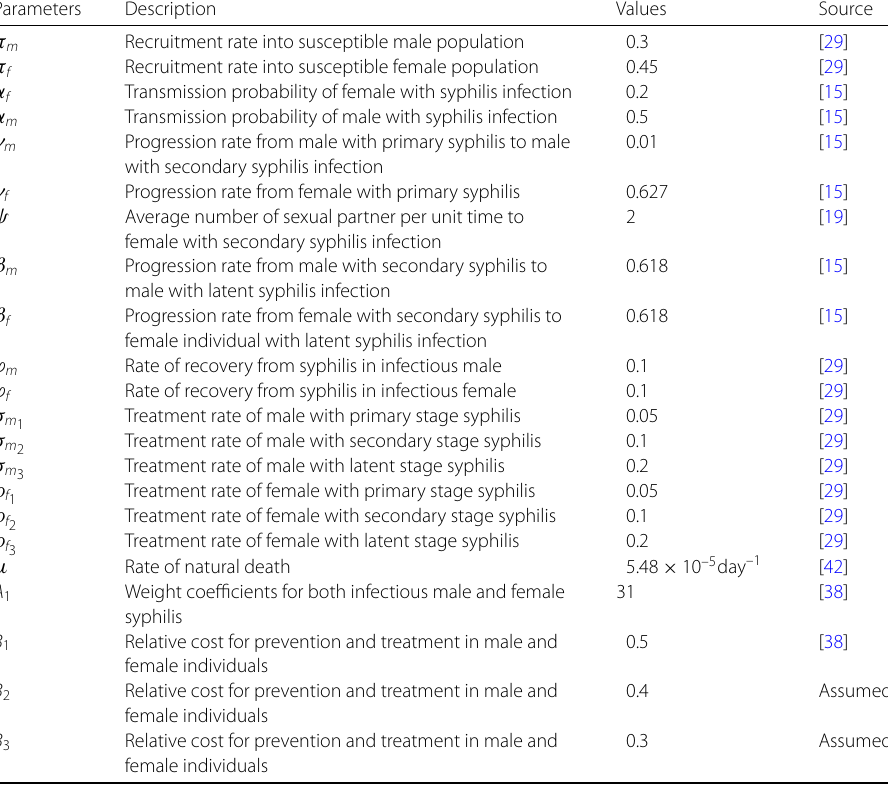
Table 2 Syphilis model parameters notation and